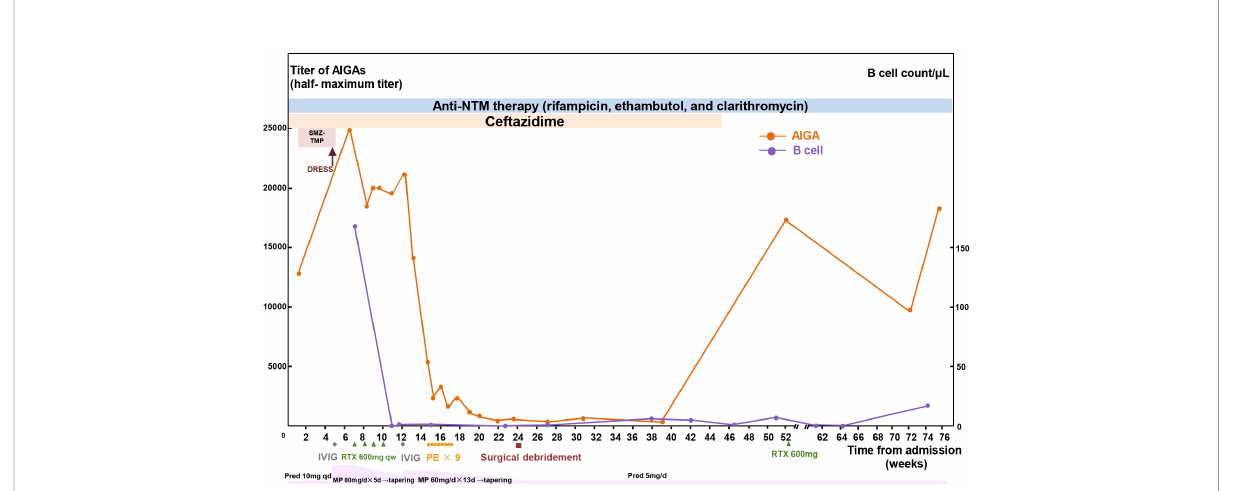
FIGURE 3 Summary of clinical course. The concentrations of half-maximum titers of AIGAs and circulating B-cell counts during the process of treatment. AIGA, anti – interferon- g autoantibodies; MP, methylprednisolone; Pred, prednisone; DRESS, drug reaction with eosinophilia and systemic symptoms; SMZ-TMP, sulfamethoxazole-trimethoprim; NTM, non-tuberculous mycobacteria; RTX, rituximab; IVIG, intravenous immunoglobulin; PE, plasma